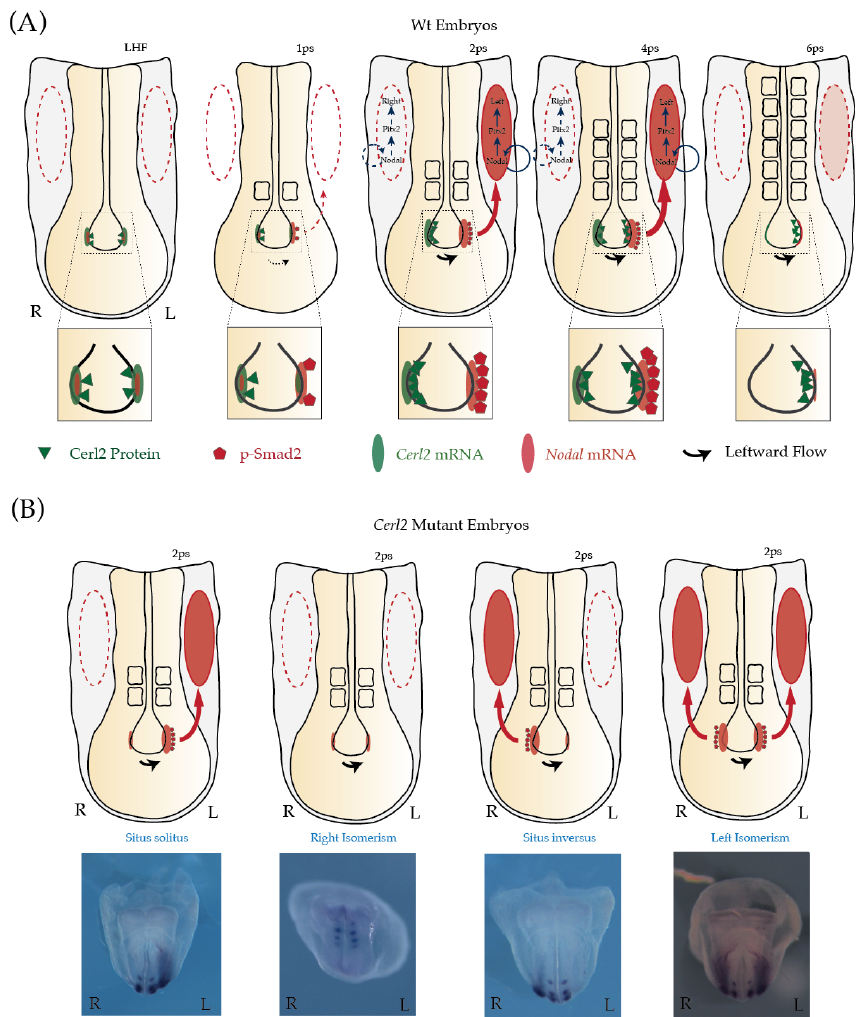
Figure 1. Sequential Nodal activity in left-right asymmetry at the mouse node during early somitogenesis. Nodal expression is represented in light red oval, and Cerl2 expression in light green oval. Cerberus-like 2 (Cerl2) protein is illustrated in green triangles, and the readout of Nodal signaling, pSmad2/3, is indicated in red pentagons. The expression of Nodal in the lateral plate mesoderm (LPM) of mouse embryos is represented by the filled red oval. Dashed to thicker lines indicate increase in intensity. ( A ) At the one-somite stage, as soon as the cilia at the node began to rotate generating a weak leftward flow, the asymmetric expression of Cerl2 (L < R) is established. This local reduction of Cerl2 mRNA (and Cerl2 protein) in the perinodal cells on the left side of the node results in an increase of active Nodal signal, i.e., pSmad2/3. At the 2-somite stage, Cerl2 protein (green triangles) localizes and prevents the activation of Nodal genetic circuitry on the right side of the embryo (dashed red oval). Later, due to nodal flow, Cerl2 right-to-left translocation shutdowns Nodal activity in the node and consequently affects the activity of Nodal in the LPM (dashed red oval). ( B ) In the absence of Cerl2 in the node, the expression of Nodal in LPM becomes